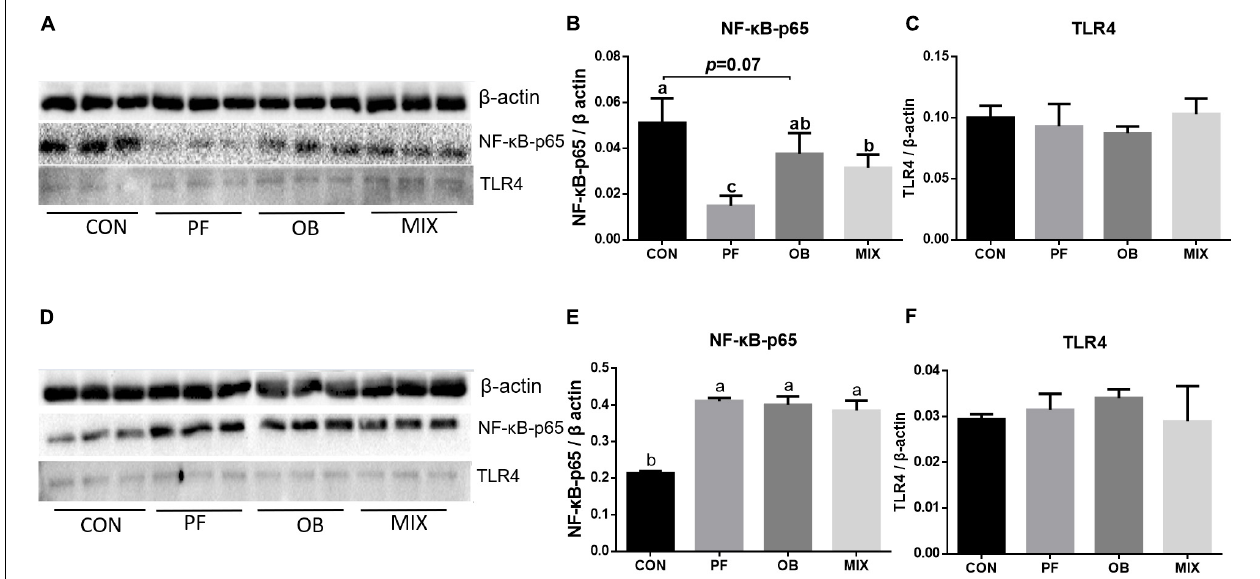
FIGURE 2 | The expression of TLR4 and NF- κ B proteins in the ileal and colonic tissues of growing pigs in CON, PF, OB, and MIX groups. (A) The profile of sodium dodecyl sulfate–polyacrylamide gel electrophoresis (SDS-PAGE) of β -actin, NF- κ B–p65, and TLR4 proteins in the ileal mucosa. (B) The average relative abundance (fold) of protein NF- κ B–p65 to β -actin in the ileal mucosa. (C) The average relative abundance (fold) of protein TLR4 to β -actin in the ileal mucosa. (D) The profile of SDS-PAGE of β -actin, NF- κ B–p65, and TLR4 proteins in the colonic mucosa. (E) The average relative abundance (fold) of protein NF- κ B–p65 to β -actin in the colonic mucosa. (F) The average relative abundance (fold) of protein TLR4 to β -actin in the colonic mucosa. Different lowercase letters in the bar graphs indicate significant differences between two groups ( p < 0.05, n = 3). CON, control group; PF, 15% pea-hull fiber in the diet; OB, 15% oat bran in the diet; MIX, 7.5% pea-hull fiber and 7.5% oat bran in the diet.